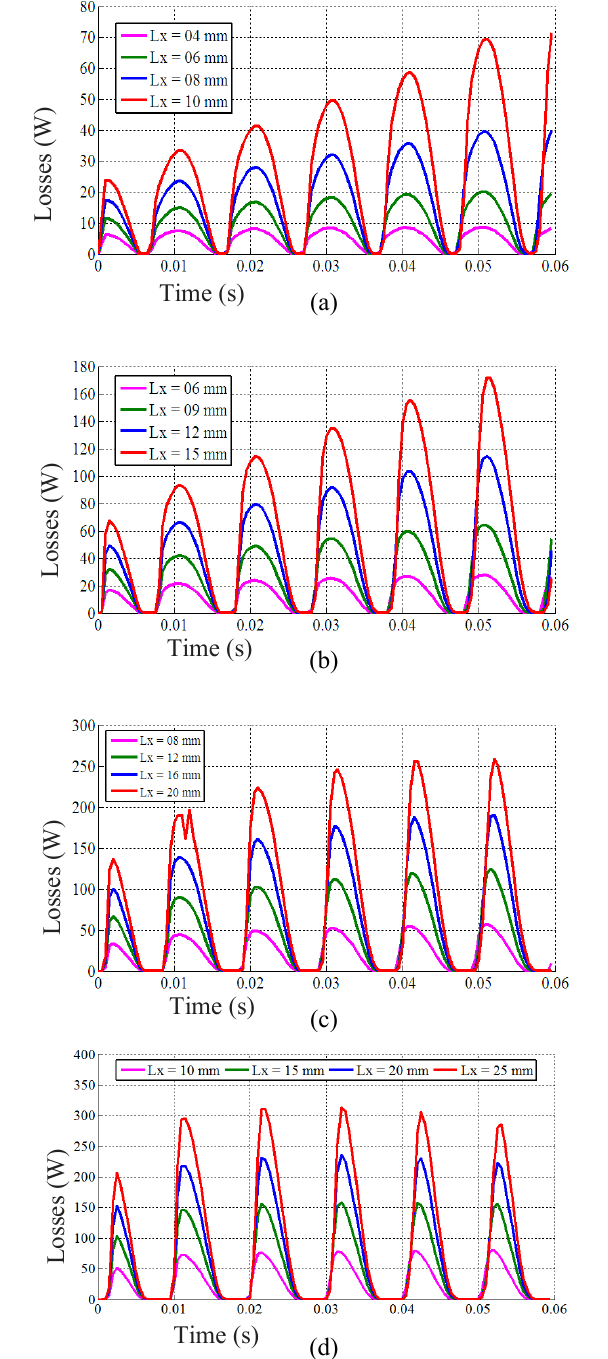
Figure 10: Losses variation as a function of Lx in the different pellet respectively (a) pellet A , (b) pellet B , (c) pellet C and (d) pellet D